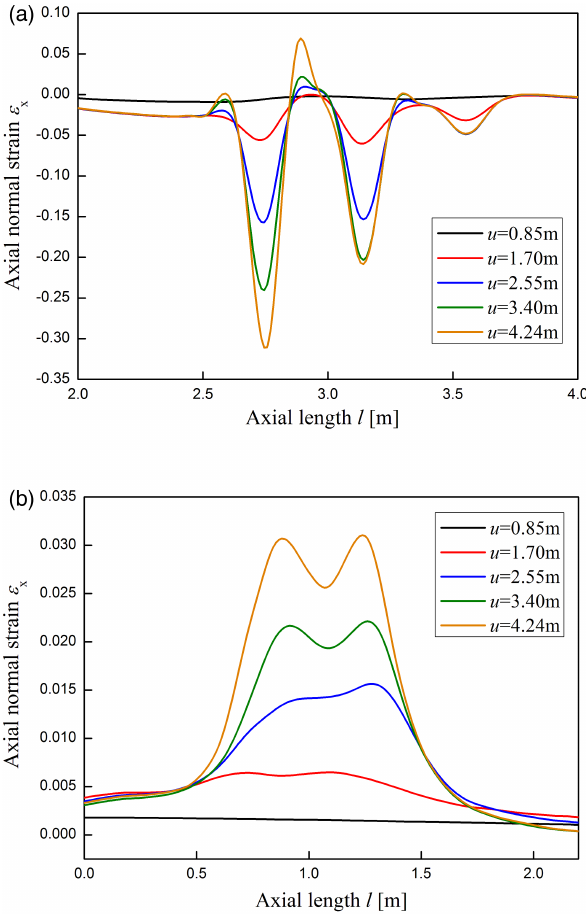
Figure 6. Variation of axial strain of the buckling area on section D under different reverse fault displacements. (a) Axial strain at the compression side and (b) axial strain at the tension side.